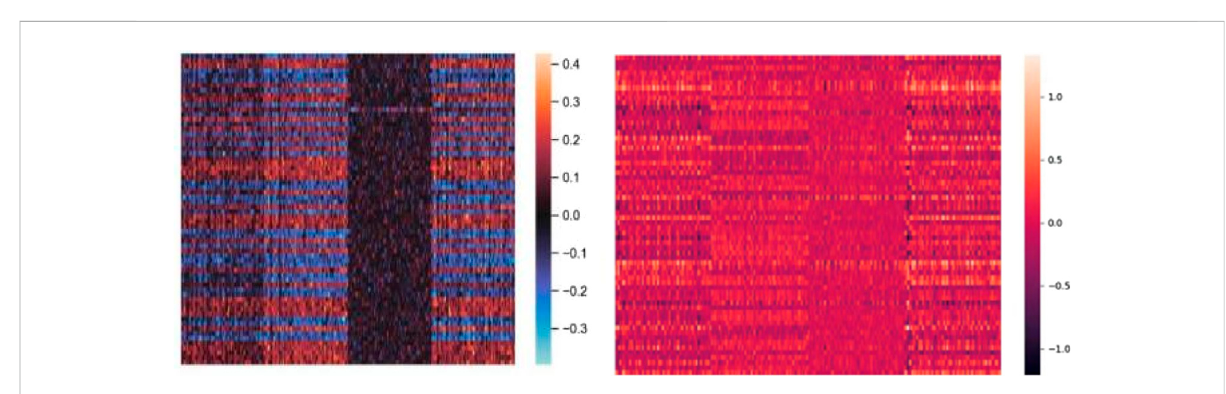
FIGURE 3 The RMSE based on different GCN and LSTM blocks.